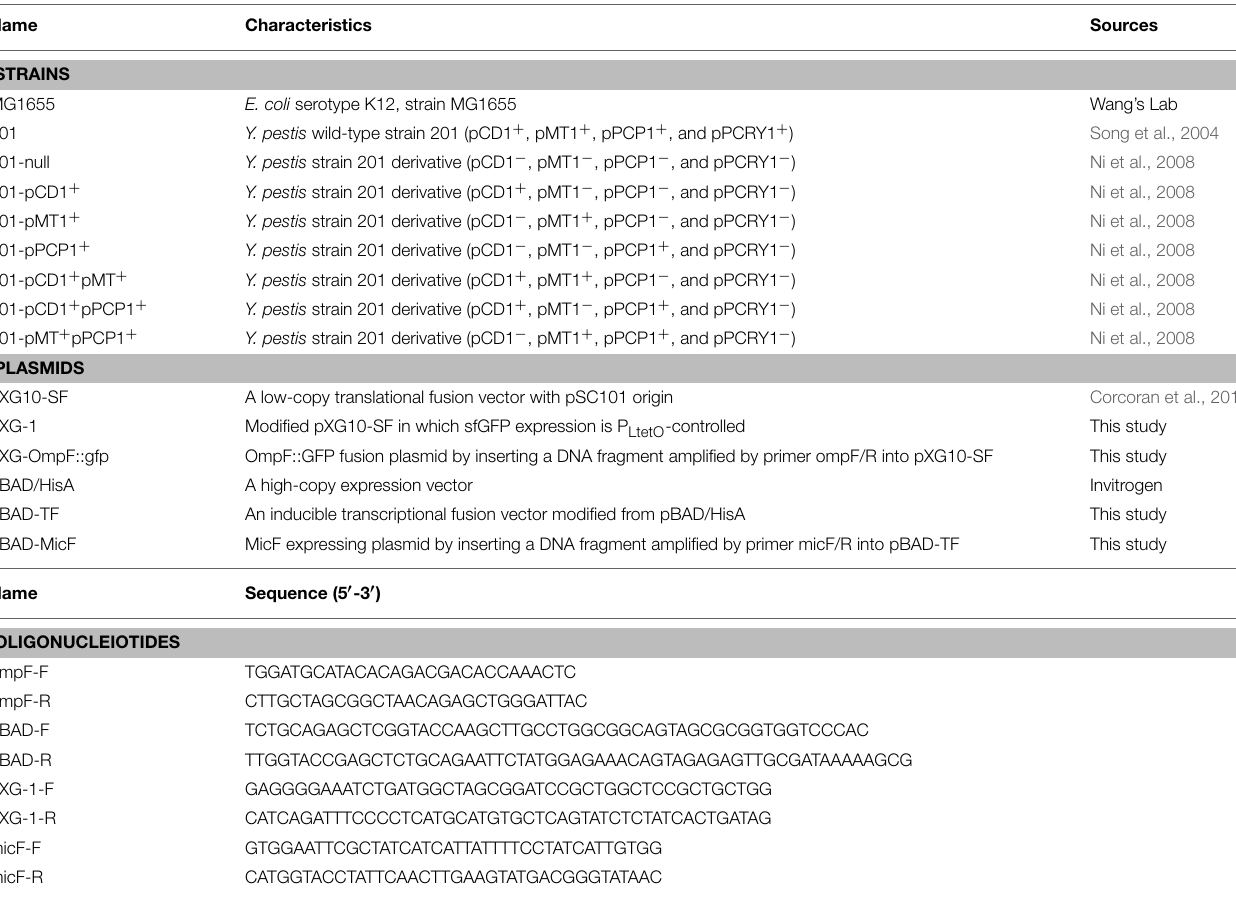
TABLE 1 | Bacterial strains, plasmids, and oligonucleiotides used in this